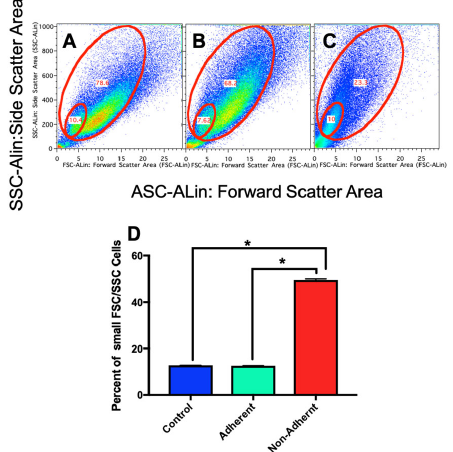
Figure 5. The percentage of small FSC vs. SSC population relative to the total in control ( A ) and sim- µg-treated adherent ( B ) and non-adherent ( C ) populations. The percentage of small cells based on FSC vs SSC in each of these groups is then graphed in ( D ) * p < 0.0002.